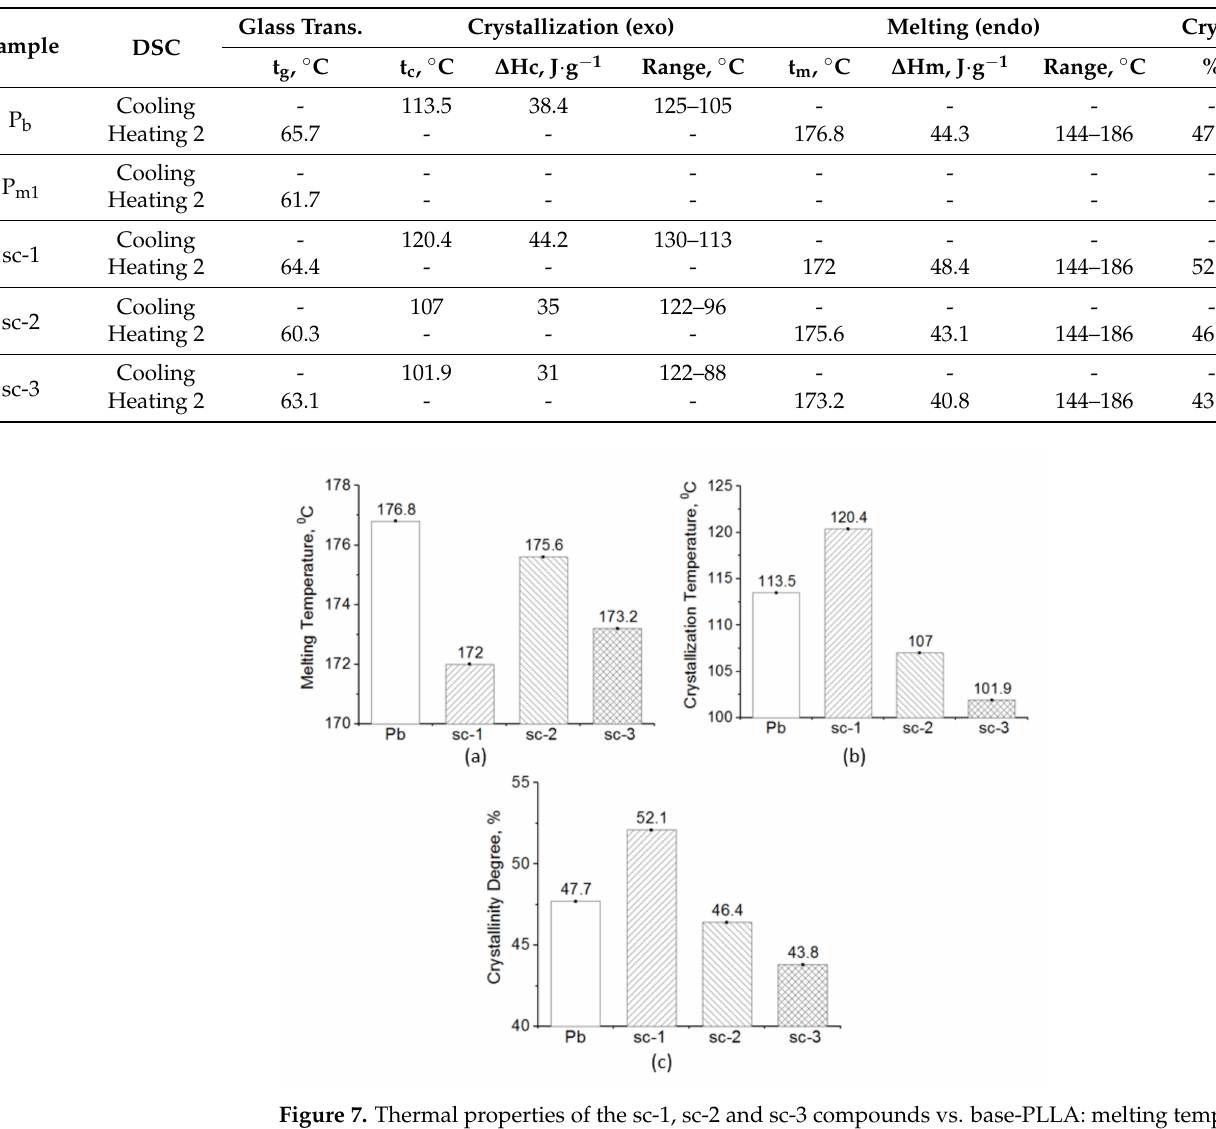
Table 6. DSC behavior of the sc-1, sc-2 and sc-3 compounds and of the blended polymers (P b and P m1 ).